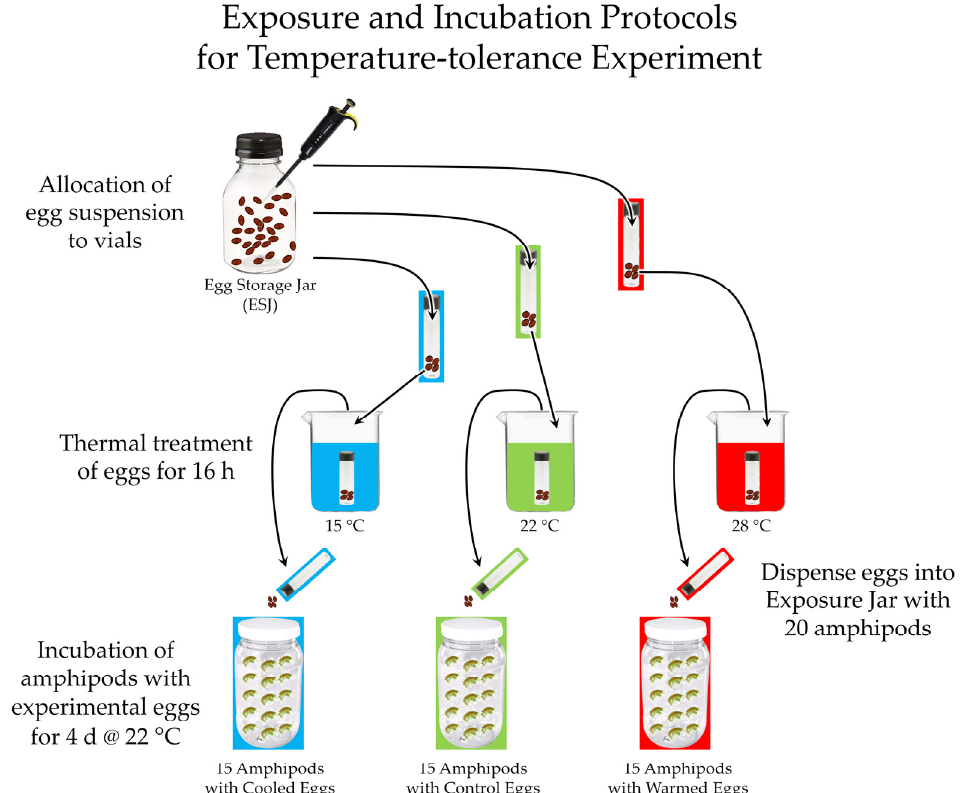
Figure 6. Design of experiment to determine if temperature extremes recorded at the site where Huffmanela huffmani prevalence declined at the greatest rate can help explain the limited downstream distribution of the parasite in the San Marcos River.